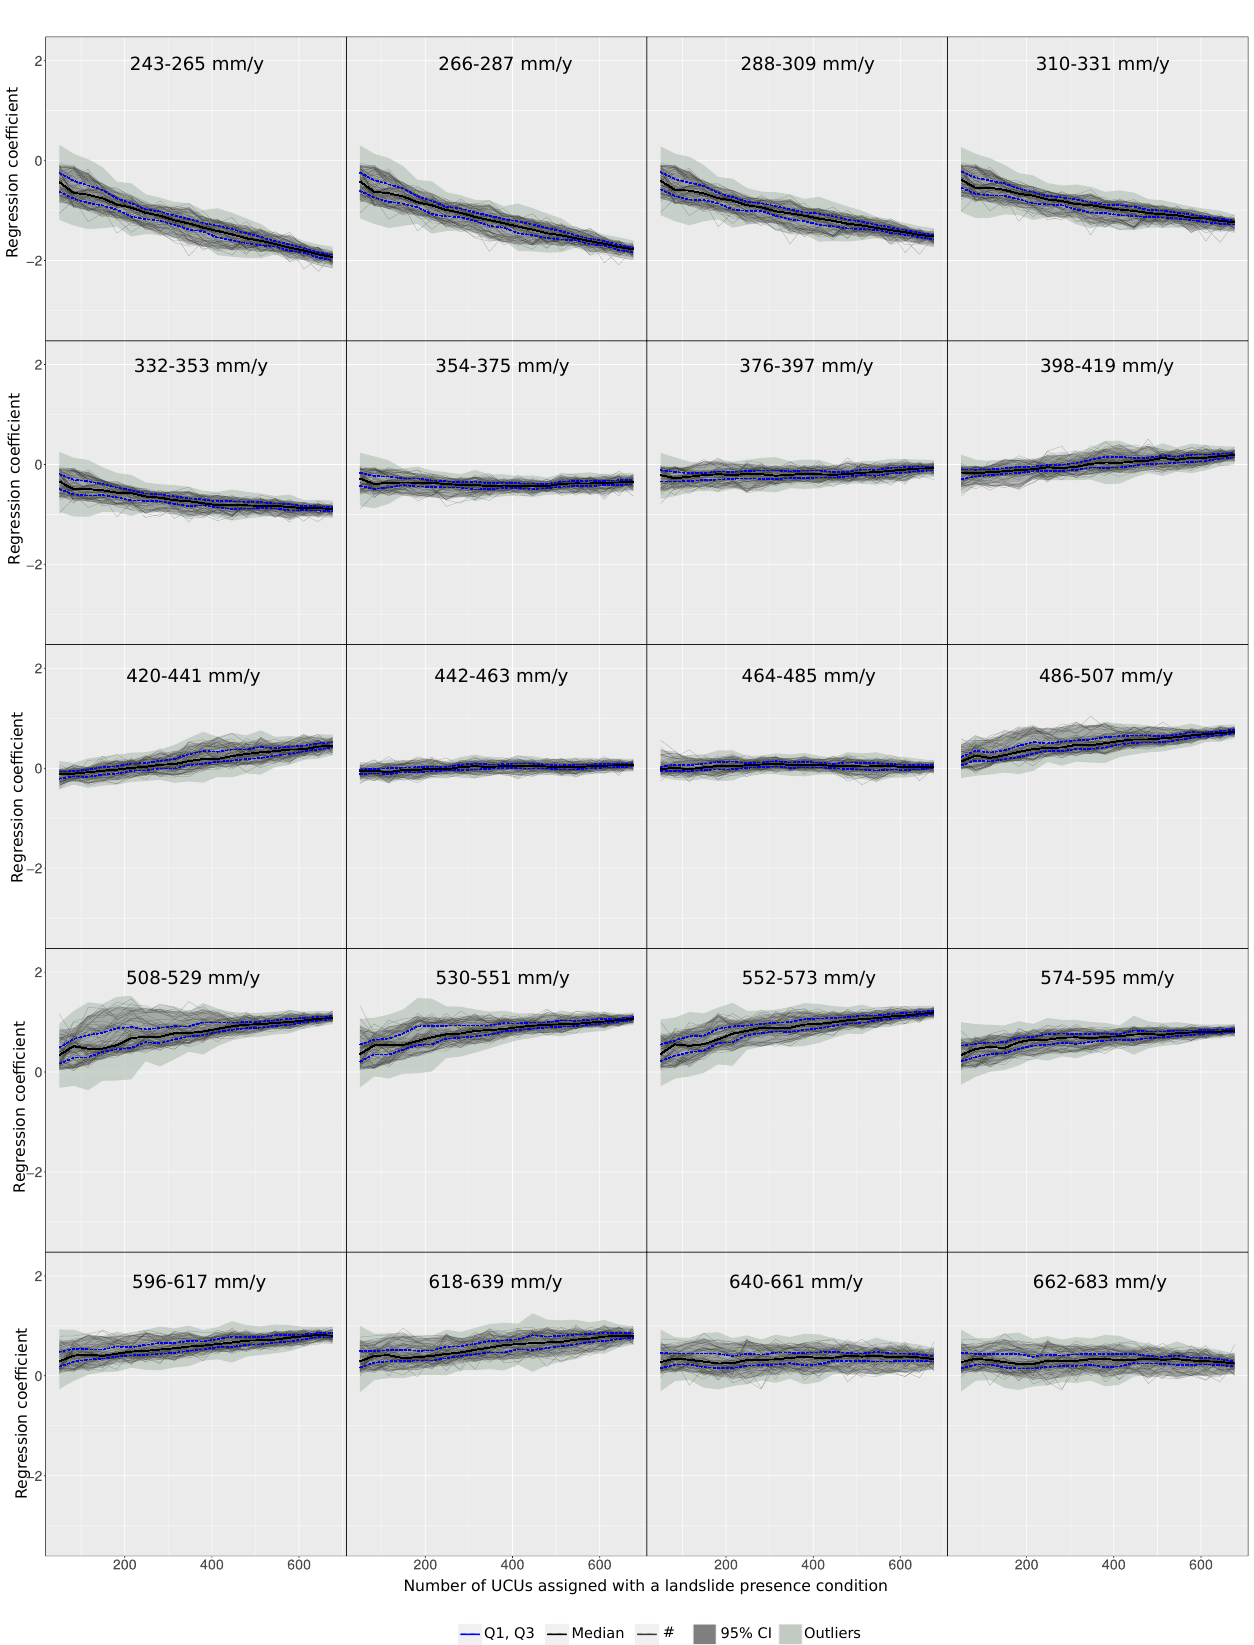
Figure A5. Mean annual precipitation effect graphical summary at a varying proportion of landslide presence